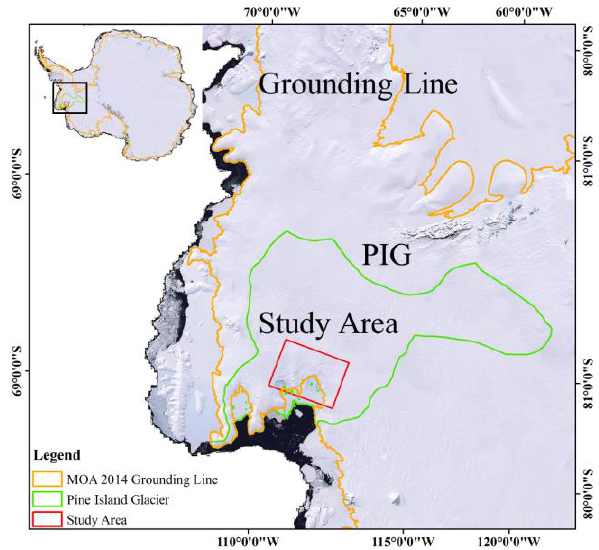
Figure 1 . The location of study area. These two layers are overlaid on the Landsat Image Mosaic of Antarctica (LIMA, (Bindschadler et al., 2008)).